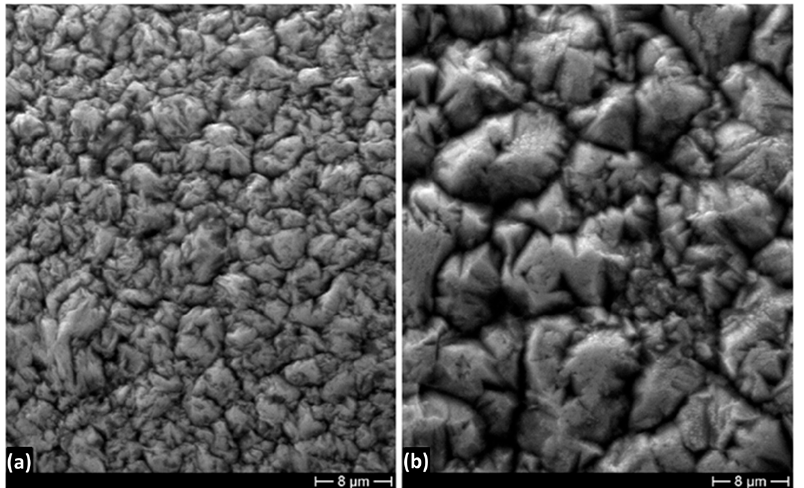
Figure 7. SEM micrographs showing the morphology of Ni deposits obtained at 250 A/m 2 CD and ( a ) 20 ◦ C and ( b ) 50 ◦